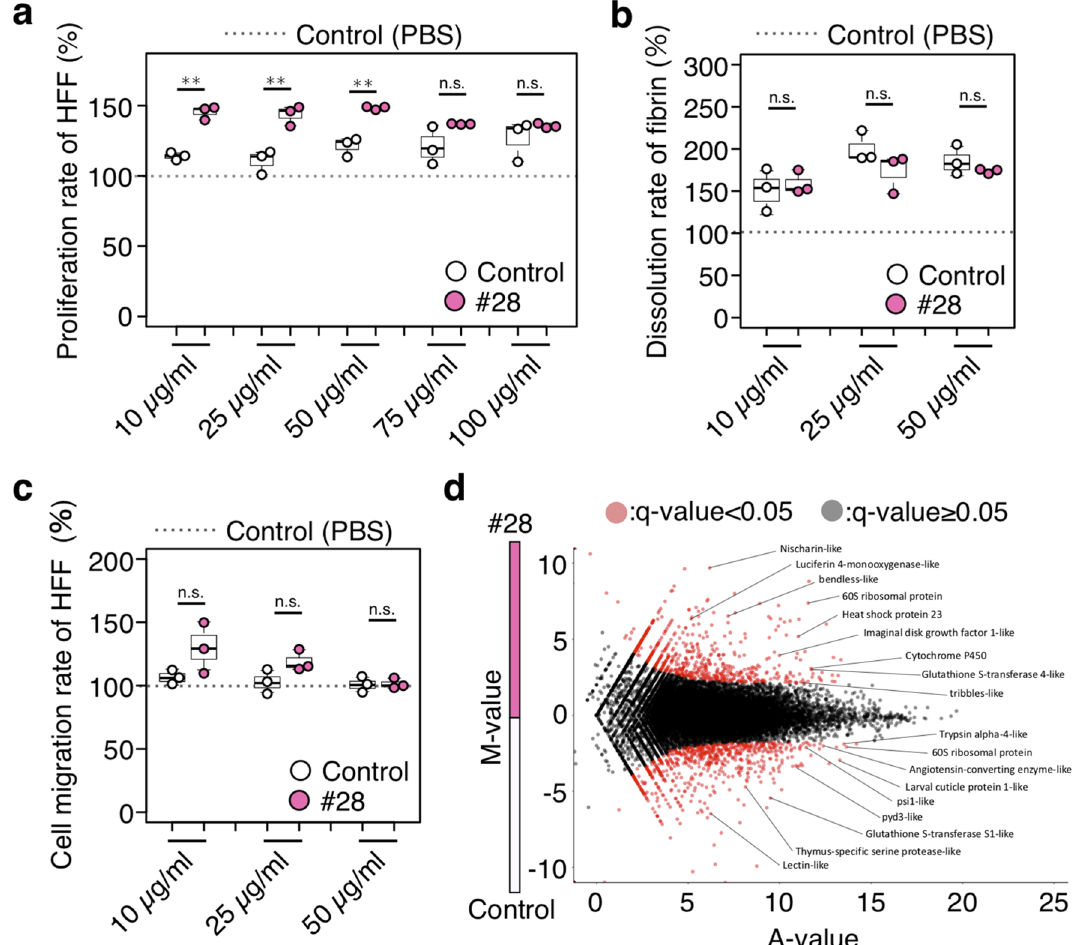
Figure 6. Cell proliferation activity of larval excretions and secretions (ES). ( a ) Proliferation rate of HFF cells treated with the indicated concentration of larval ES. n = 3 per group. ( b ) Dissolution rate of fibrin by culture supernatant of HFF cells treated with the indicated concentrations of larval ES. n = 3 per group. c Cell migration rate of HFF cells treated with the indicated concentration of larval ES. n = 3 per group. Each dot represents the value obtained from an individual specimen ( a – c ). Each rate is expressed as the percentage of larval ES-treated condition versus PBS only treatment (shown as 100%). Boxplots: center line, median; box range, 25th–75th percentiles; whiskers denote minimum–maximum values. Student’s t -test, ** p < 0.01. n.s., not significant. See also Supplementary Data 1 for data of experiment, exact sample sizes, and p values. ( d ) MA plots of RNA sequence reads of control strain, compared with strain #28. Genes with q-value < 0.05 are labeled in red. M, log 2 fold change, A, averaged log 2